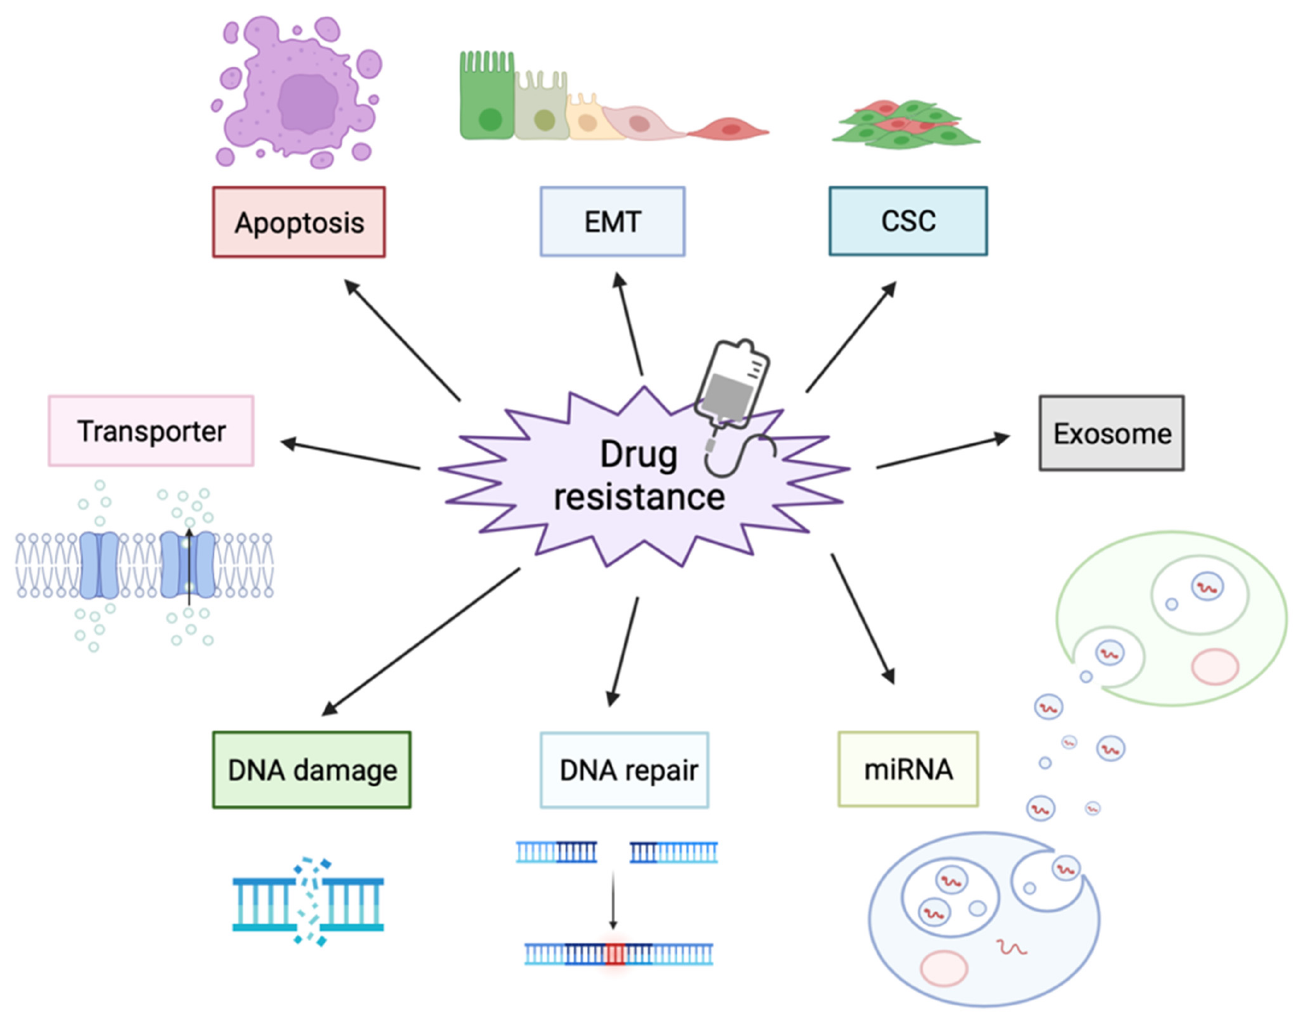
Figure 3. Resistance Mechanisms to Anticancer Drugs in Oral Cancer. Cancer cells use a variety of mechanisms to reduce the efficacy of anticancer drugs, such as increasing transporter, inducing EMT, emitting anticancer drugs in EVs, and DNA repairing.